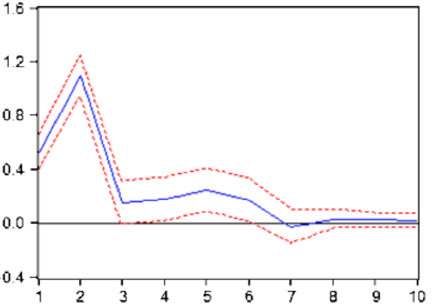
Figure 3. Impulse response of Shanghai copper to New York copper yield.